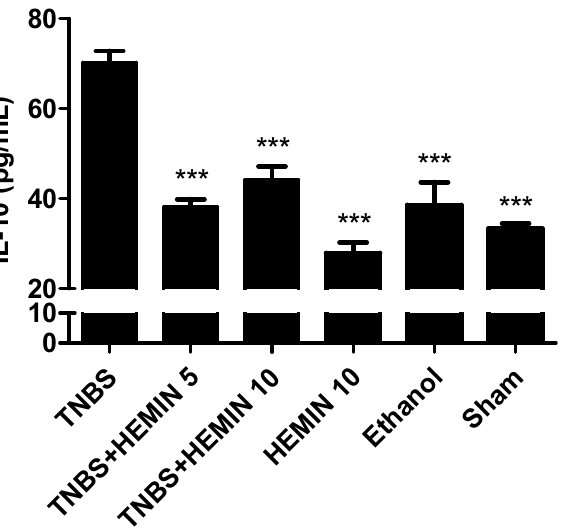
Figure 6. Effect of hemin treatment on IL-10 concentration in the IBD. Legend: One-way ANOVA for multiple comparisons and Tukey’s post hoc test. *** p < 0.001; compared with TNBS group.